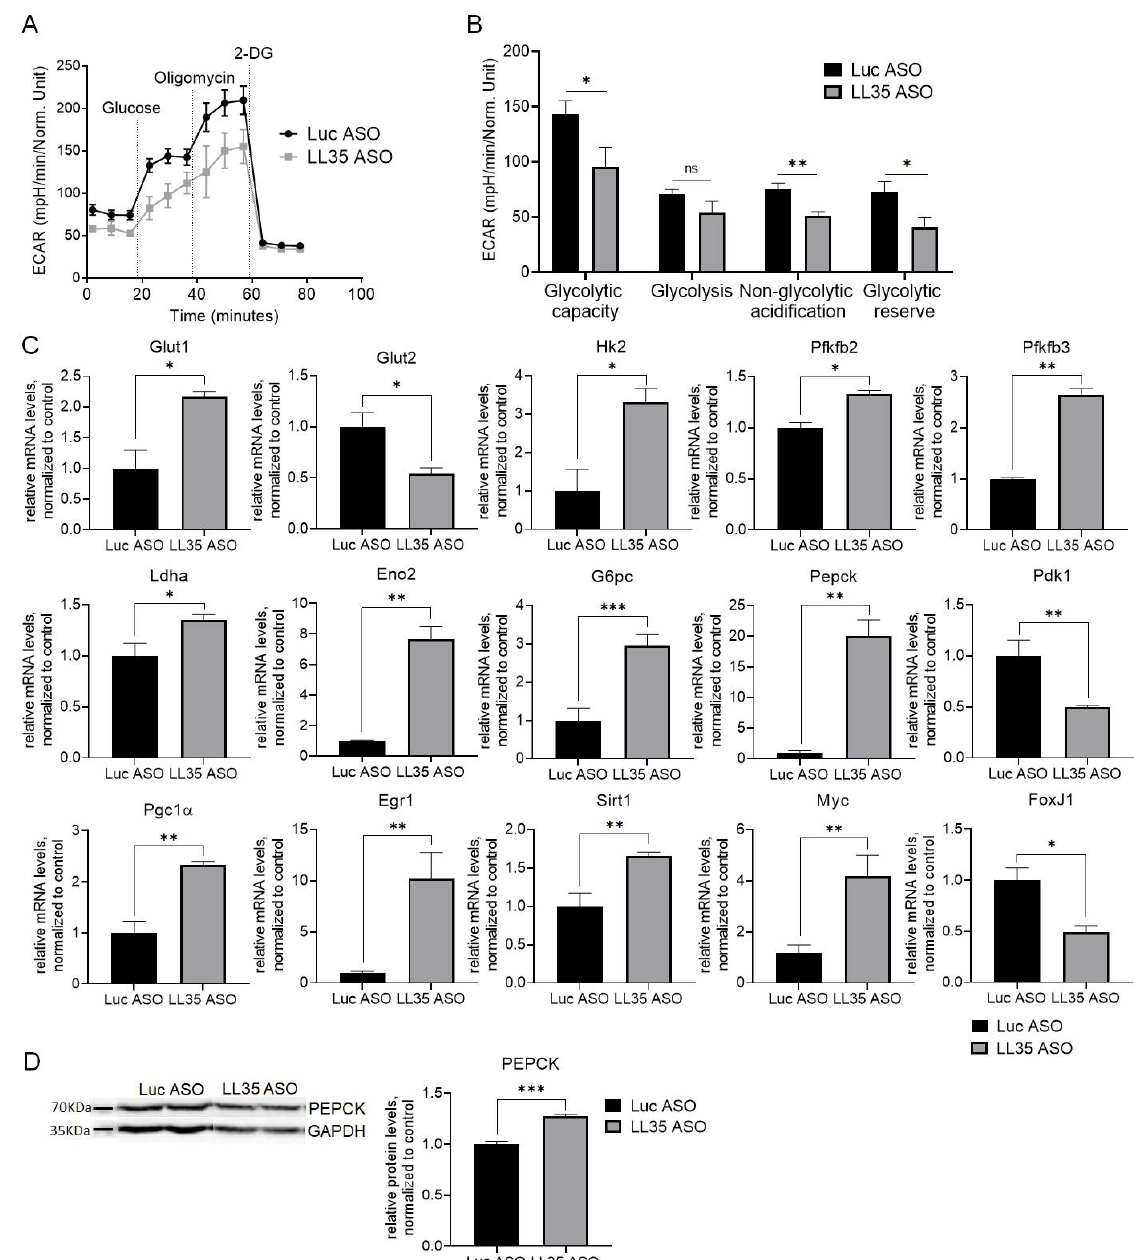
Figure 5. Changes in the glucose metabolism after LL35 knockdown in vitro. ( A ) An averaged time curve for ECAR after subsequent injections of 10 mM glucose, 1 μ M oligomycin and 50 mM 2-DG. Each data point represents an ECAR value used for calculations. ( B ) Individual parameters for cell glycolytic function, including glycolytic capacity, glycolysis, non-glycolytic acidification and glycolytic reserve, for AML12 cells after LL35 depletion (LL35 ASO) and control (Luc ASO). ( C ) Evalu- ation of mRNA levels for key genes and transcription factors, which participate in glucose metabolism after LL35 knockdown (LL35 ASO) and control (Luc ASO) by RT-qPCR with normalization on ACTB gene. ( D ) Western blot and its quantification of PEPCK protein levels in AML12 cells after LL35 inhibition (LL35 ASO) and control (Luc ASO). Results show mean ± SD. ns—not significant. * p < 0.05, ** p < 0.01 and *** p <